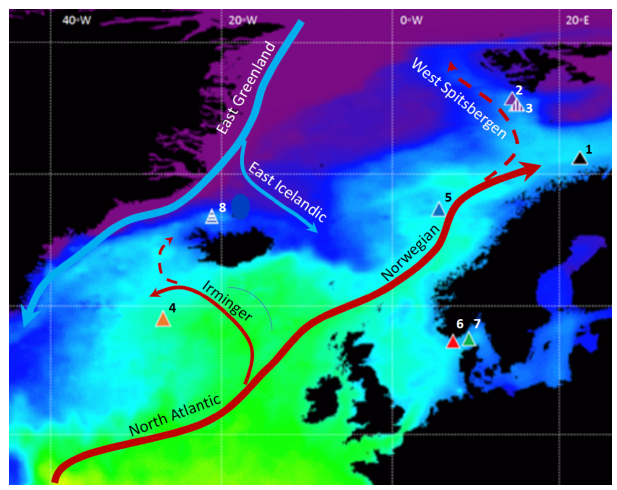
Figure 1. Location of sediment cores used to obtain the alkenone- based paleo SST estimates shown in Fig. 2. Site numbers corre- spond to those in Fig.